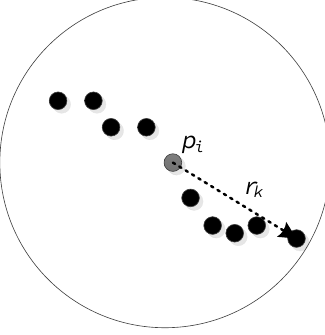
Figure 2. Calculation of the local point cloud density.